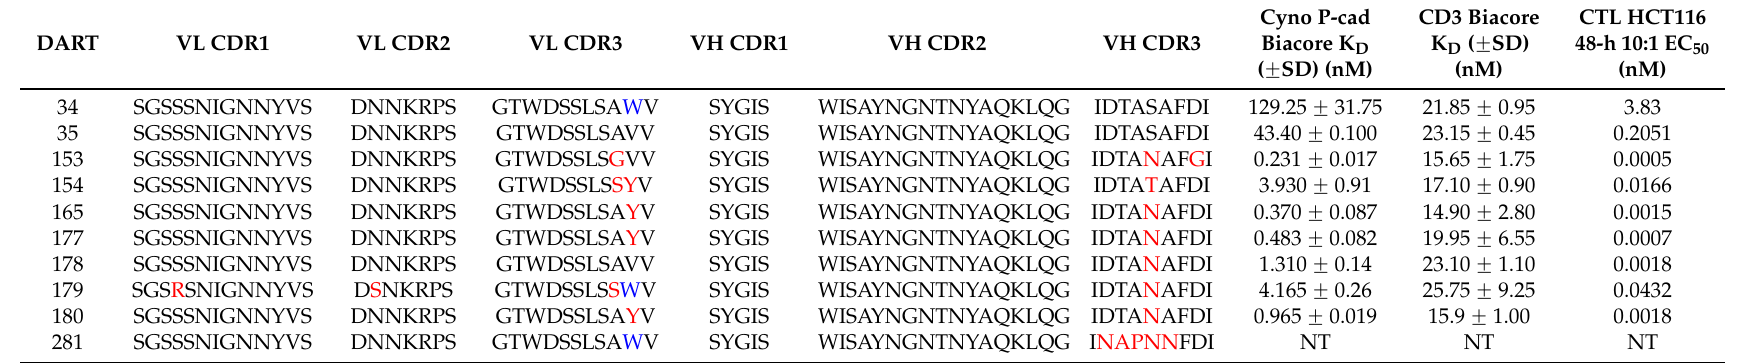
Table 3. Alignment of complementarity determining region (CDR) sequences with equilibrium dissociation constants and cytotoxicity EC 50 values of affinity optimized anti-P-cadherin DARTs compared to parental